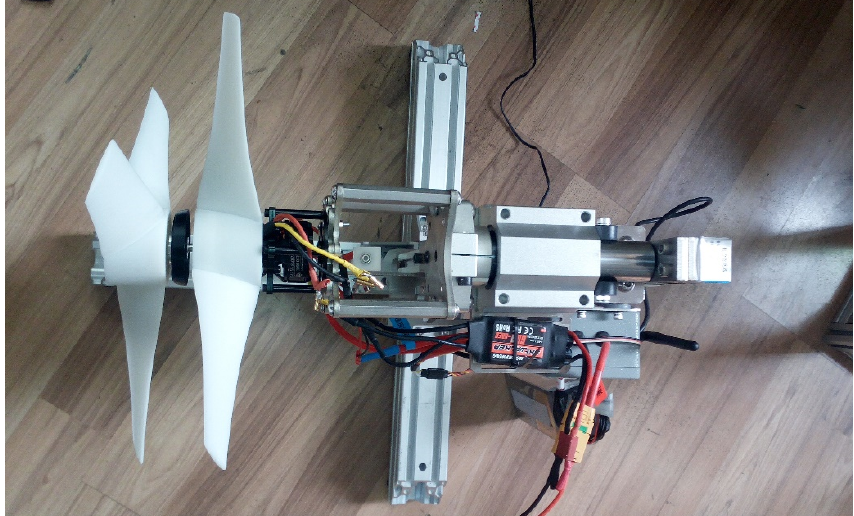
Figure 2. Experimental setup.